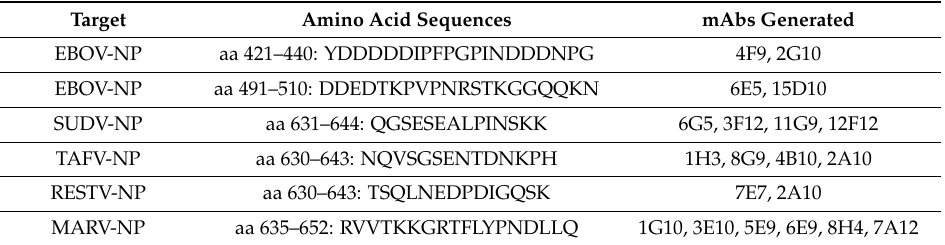
Table 1. Filovirus nucleoprotein (NP) peptides sequences for mice